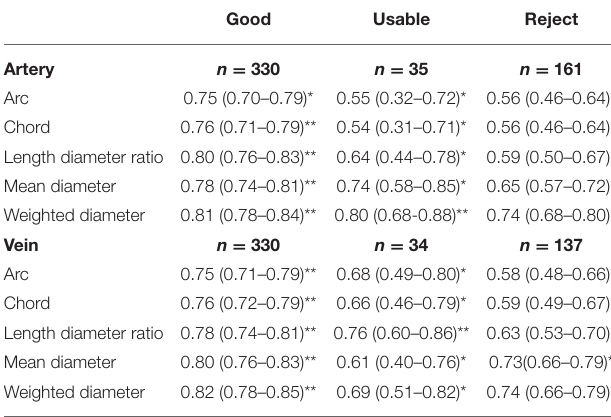
TABLE 5B | Agreement estimates of measurements based on the whole fundus on photographs taken repeatedly under similar